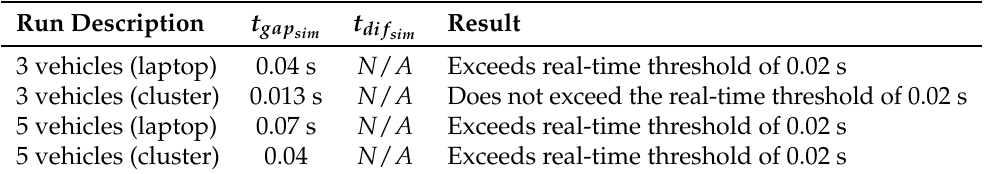
Table 4. Evaluation of the real-time capabilities of the simulation runs presented in [40]. Due to the single-core execution of the scenario, t dif is never available. Result evaluations are derived from sim findings in